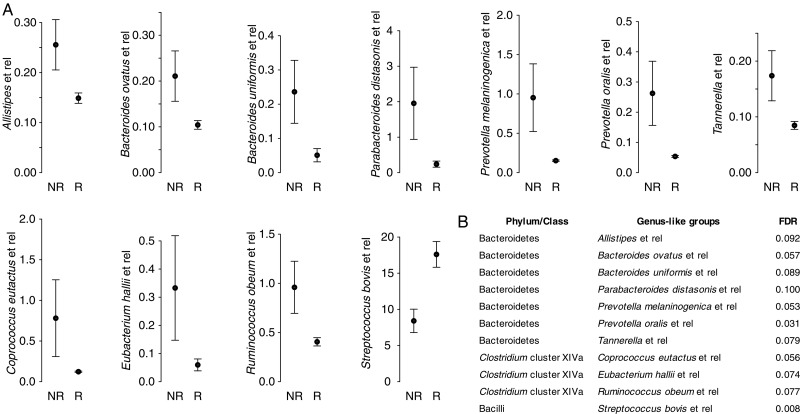
A, Comparison of the relative abundance (median
signal intensity) of all bacterial genuslike groups with a
statistically significant (false discovery rate [FDR] <0.1)
difference in abundance between Ghanaian rotavirus vaccine (RVV)
responders (R) and nonresponders (NR). Plots show means with
standard errors. B, The FDR for each of the
significantly different genera.